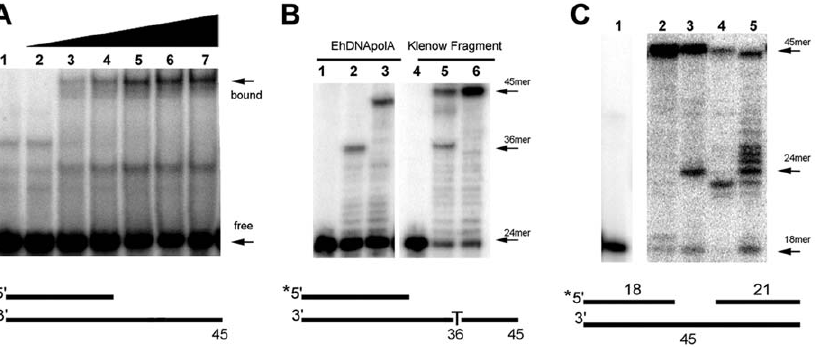
Figure 3. Biochemical characterization of EhDNApolA. ( A ) EhDNApolA binds to double stranded DNA. Increasing concentrations of recombinant EhDNApolA (from 0 to 180 nM) were incubated with a fixed amount of double stranded primer-template. The binding of the EhDNApolA to the primer-template is observed by the formation of a slower migrating complex on a native 6% polyacryalmide gel. ( B ) EhDNApolA is an active DNA polymerase. DNA polymerase activity was measured by the extension of 24mer primer annealed to a 45mer template. Lanes 1 and 4 contained reactions with no added polymerase, EhDNApolA (lanes 2 and 3) or Kf (exo-) (lanes 5 and 6). Reactions in lanes 2 and 5 were incubated with dTTP,dGTP and ddATP. Reactions in lanes 3 and 6 were incubated with all four dNTPs. Incorporation of ddATP results in extension to a 36mer and incubation with all four dNTPs results in a 45mer product. ( C ) Strand displacement activity of EhDNApolA. Strand displacement was determined using a six-nucleotide substrate gap depicted below Figure3D. The reactions contained 25 units of w 29 DNA polymerase (lane 2), 4 units of Taq DNA polymerase (lane 3), 5 units of T7 DNA polymerase (lane 4), and 45 fmol of EhDNApolA (lane 5). The 18mer primer can be freely extended to a 24mer. Further extension is only possible if the DNA polymerase displaced the annealed